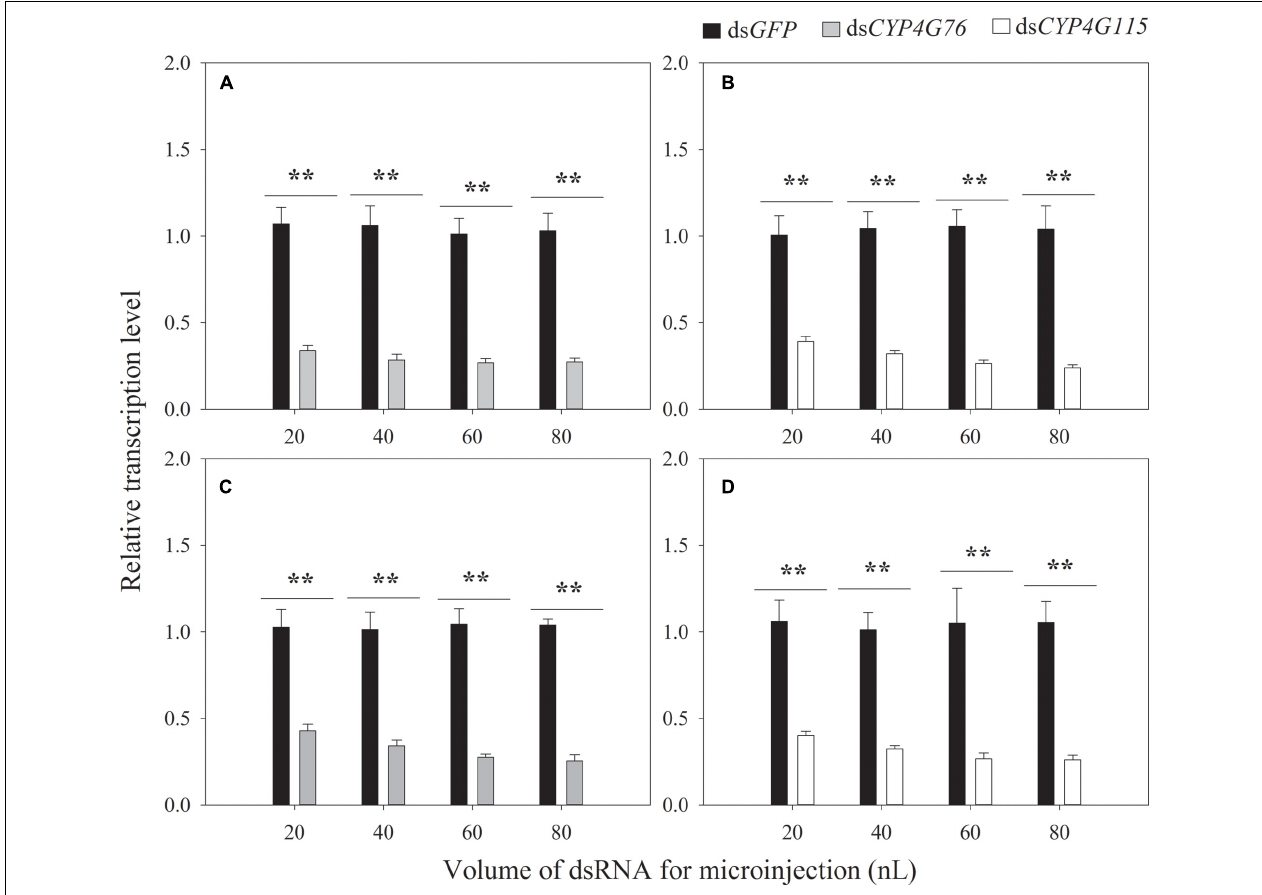
FIGURE 3 | Effect of the volume of dsRNA (1000 µ g · mL − 1 ) on the expression of CYP4G76 and CYP4G115 in third instar Nilaparvata lugens nymphs 24 h following injection. (A) injection of CYP4G76 , (B) injection of CYP4G115 dsRNA, (C,D) the injection of commingled dsRNA containing ds CYP4G76 and ds CYP4G115 (1:1). The nymph injected dsRNA was collected at 24 h and the transcript levels of CYP4G76 and CYP4G115 were analyzed by qRT-PCR. Mean ± SE was calculated from five biological replicates, and each biological replicate contained ten third instar N. lugens nymphs. ∗∗ in each figure showed significant difference between treatments and control (Student’s t -test, p <